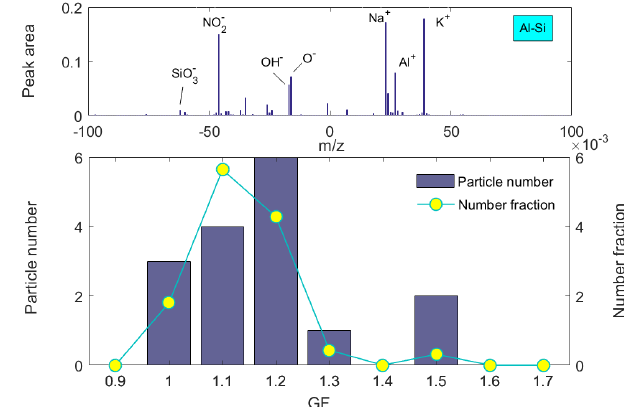
Figure 3. Average mass spectra and hygroscopicity distribution of Al-Si